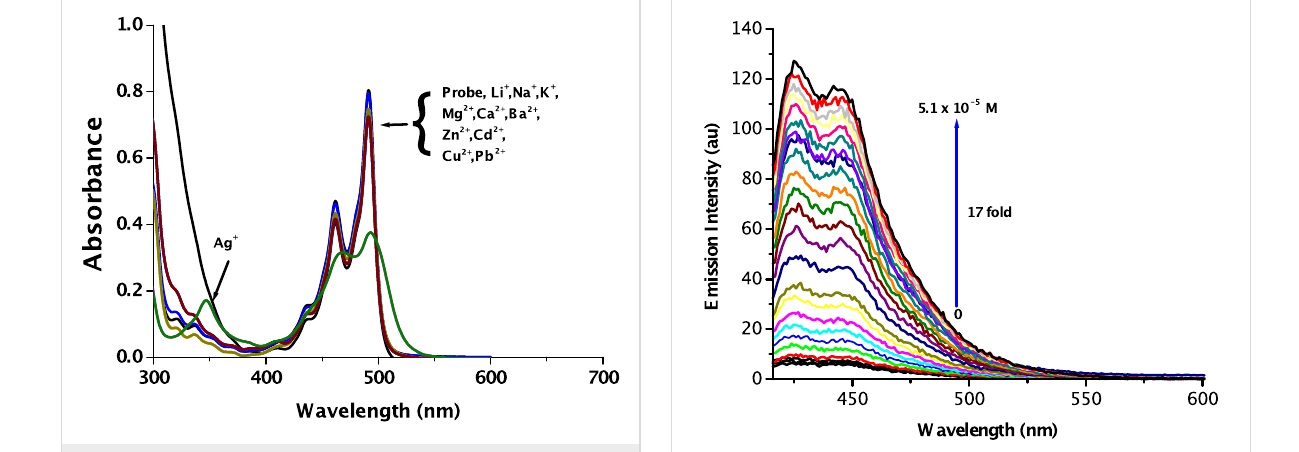
Figure 2: Spectrophotometric investigation of acrithion 2 (2.83 × 10 − 5 M) with metal ions (2.83 × 10 − 3 M) in DMSO–H 2 O (70:30 v/v) at pH 7.4.